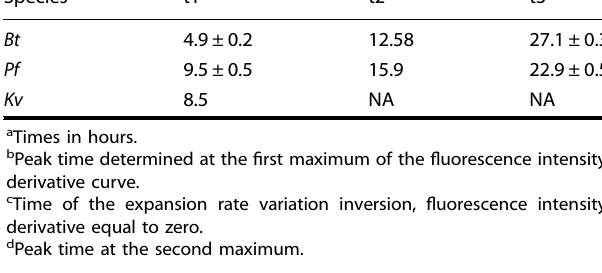
the bio fi lm development, despite short-length scale heterogene-